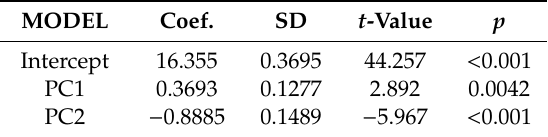
Table 1. Results of generalized models of total species richness. Coef = coe ffi cient of variation in the model. SD, standard deviation and P, significance of the model. ( p < 0.05). MODEL Coef. SD t -Value